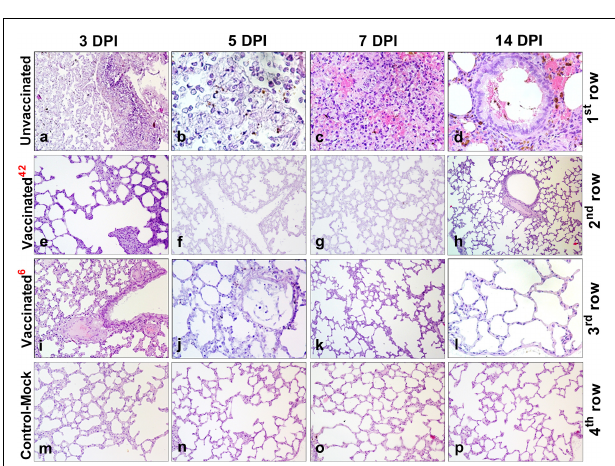
FIGURE 7 | Paraffin sections of the lungs of vaccinated and unvaccinated hamsters. Pathohistological picture of the lung of unvaccinated hamsters ( a–d , 1st row) and vaccinated hamsters challenged after 42 days ( e–h , 2nd row), and vaccinated hamsters challenged after 6 months ( i–l , 3rd row) on days 3, 5, 7, and 14, respectively after challenge with the wild homologous SARS-CoV-2 virus; 42 indicates vaccinated group challenged 42 days after vaccination; 6 indicates vaccinated group challenged 6 months after vaccination. The 4th row shows the histological picture of the lung of control hamsters on days 3, 5, 7, and 14 (m–p) , indicative of normal lung microstructure. Alveoli, bronchioles, capillaries, and the respiratory membrane are clearly observed. The images were stained with hematoxylin and eosin. Image magnification: × 400. DPI, days post